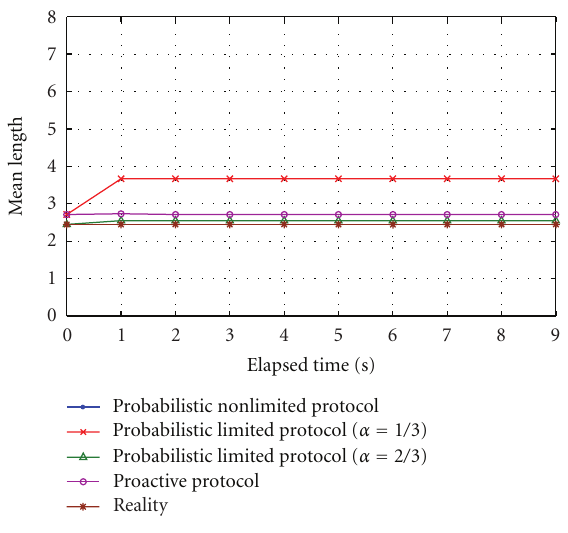
Figure 4: Average route length as a function of the elapsed time, V = 5